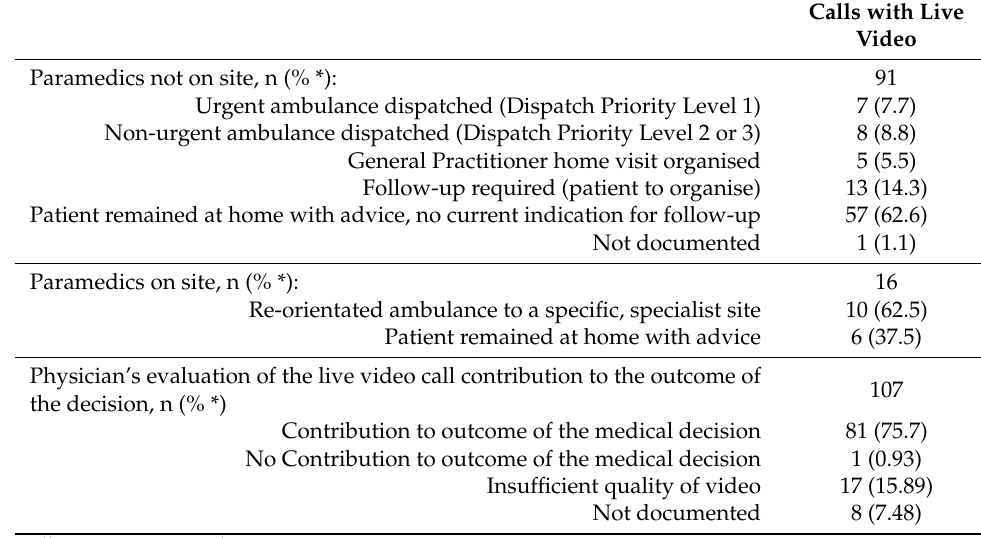
Calls with Live Video